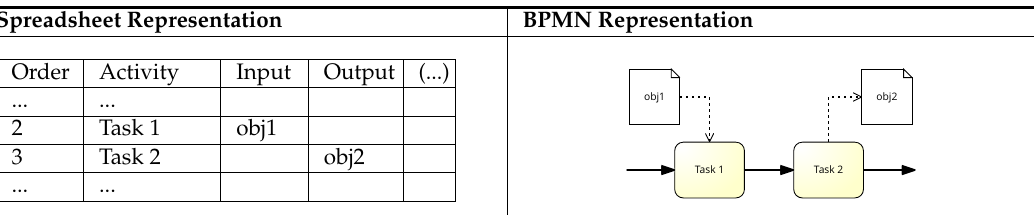
Table 15. Data object